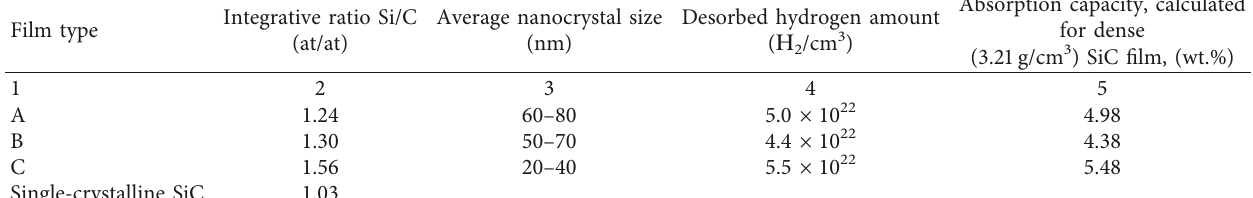
Table 1: Characteristics of the investigated film types.